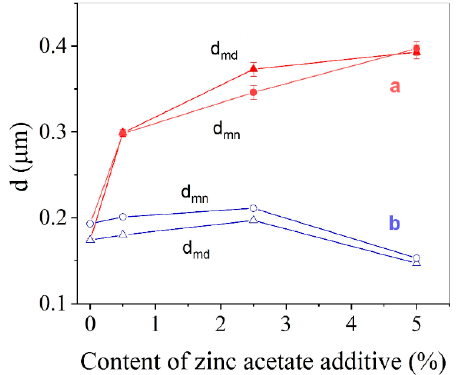
Figure 6. Mean crystal size (d mn ) and median (d md ) of the size distribution of activated ZnO powder vs. ZnAc content for two types of activation: impregnation by ZnAc followed by TVT (a); impreg- nation by ZnAc (b).